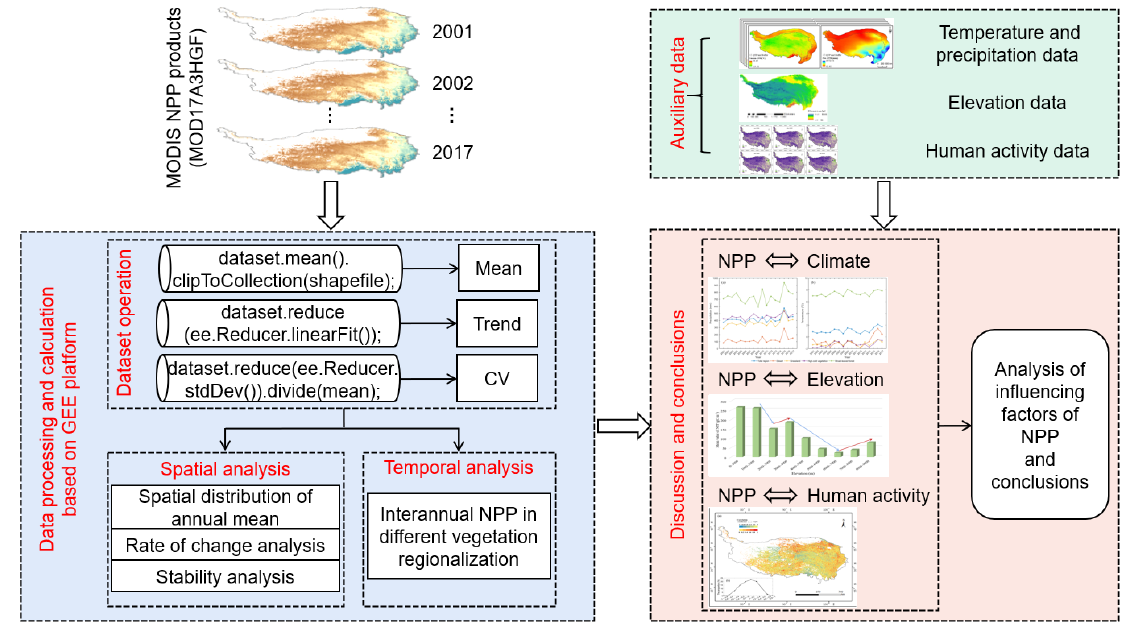
Figure 2. The workflow of the methods.